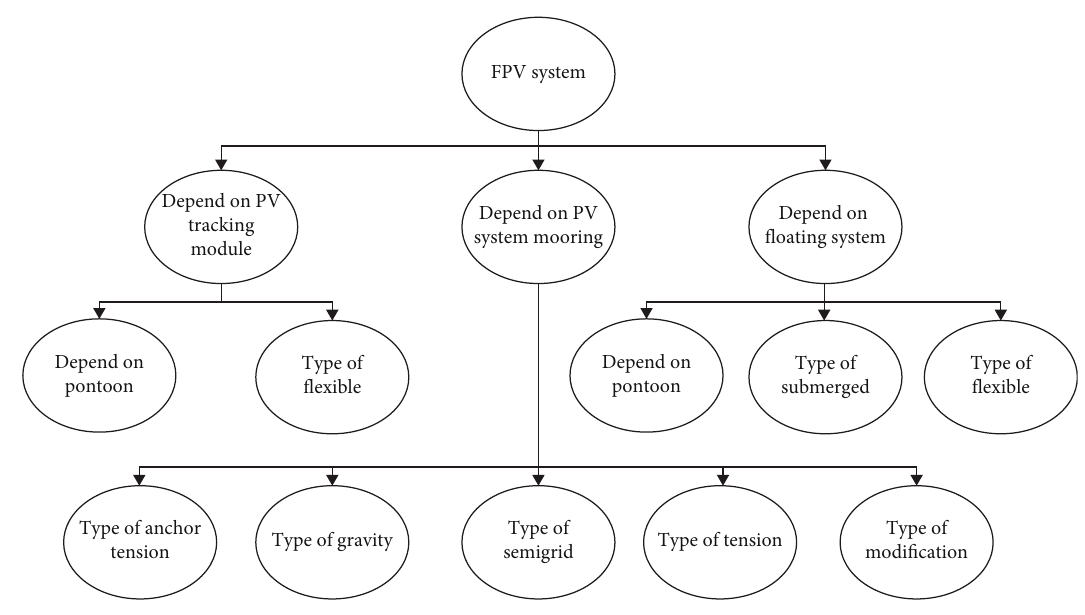
Figure 1: FPV on a di ff erent